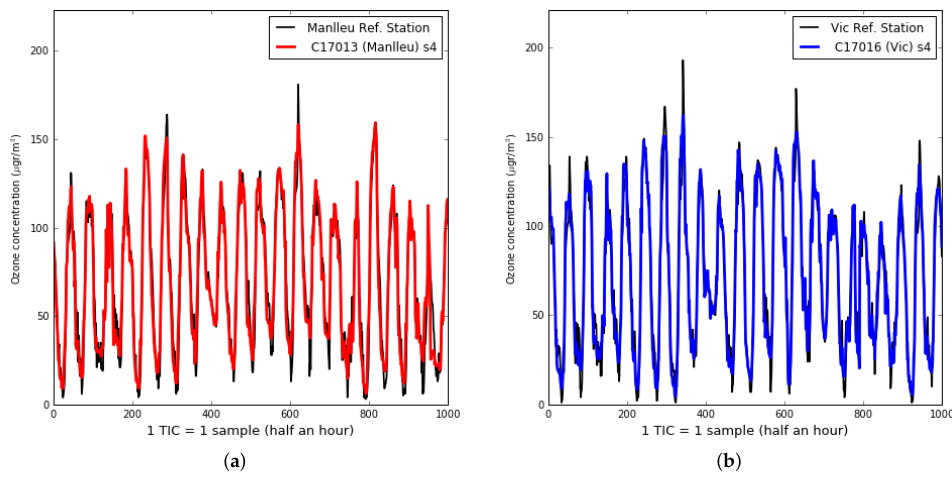
Figure 11. Case 3: Ozone concentration ( µ g/m 3 ) for ( a ) Captor node C17013 (Manlleu), ( b ) Captor node C17016